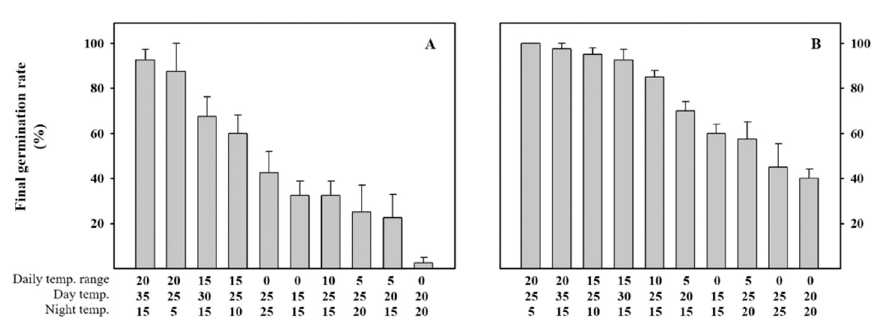
Figure 1. Final germination percentage of Agastache rugosa ( A ) and Astilbe rubra ( B ) under 10 differ- ent temperature conditions. Final germination percentage represents the value on the date when the germination percentage remained unchanged after more than 5 days. The bars represent the mean ± SE ( n =